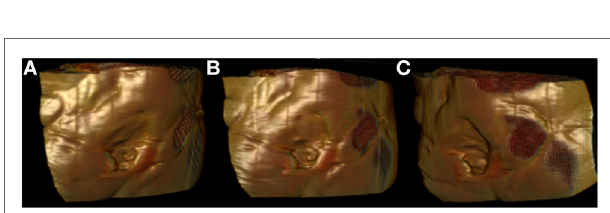
FigUre 2 | surface-rendered reconstruction images derived from a preoperative computed tomography scan, showing the three- dimensional nature of a sacral defect (a–c: three dimensional rotating views) .